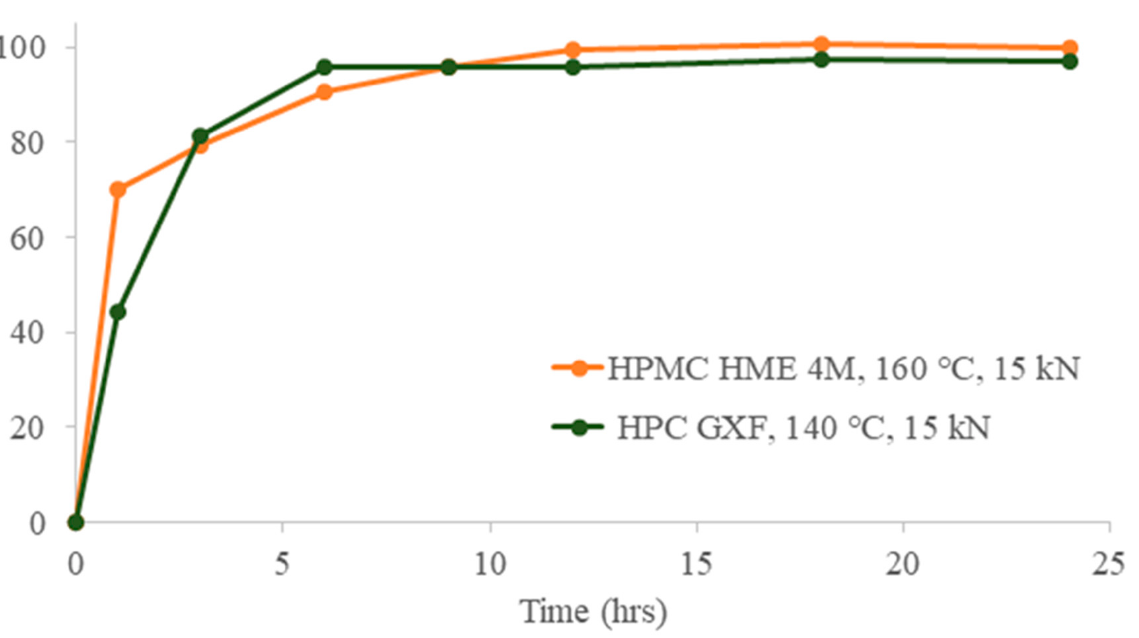
Figure 3. Dissolution profiles for tablets obtained by compaction of melt-granulated samples of metformin HCl (75% w / w )–HPC GXF (25% w / w ) and metformin HCl (75% w / w )–HPMC HME 4M (25% w / w ). Tablets with metformin HCl–HPMC HME 4M granules showed burst release of the drug in 1 h (~69%). Tablets with HPC GXF showed comparatively slower release (~44%) in 1 h. The burst release in the case of HPMC HME 4M tablets was due to the formation of large pores which facilitated faster diffusion of the drug out of the matrix.